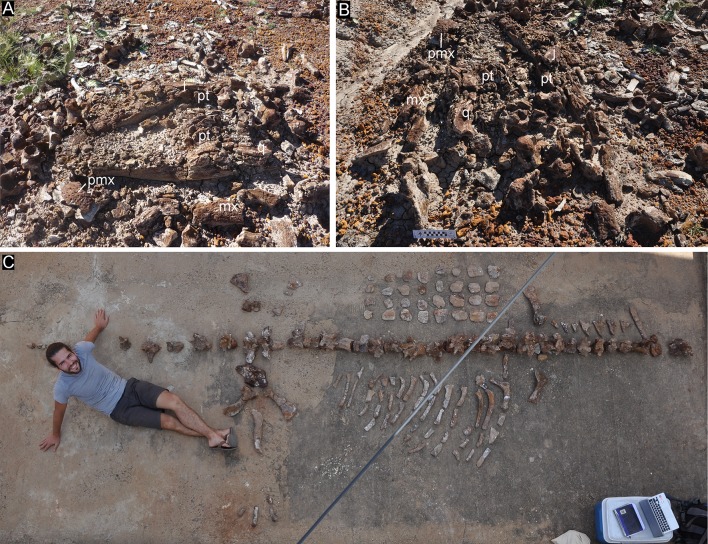
Specimen AMU-CURS-541 of Purussaurus mirandai in the field at ‘North of El Picache’ locality, Urumaco, Falcón state, Venezuela.The lower jaw is still largely articulated, whereas fragments of the skull and postcranial elements are found scattered around it. (A) lower jaw in left laterodorsal view. (B) lower jaw in posterodorsal view. (C) Postcranial bones laid out in approximate life positions. Note that osteoderms (upper part) and ribs (lower part) have been placed separately next to the vertebral column. Abbreviations: j, jugal; mx, maxilla; pmx, premaxilla; pt, pterygoid; q, quadrate.